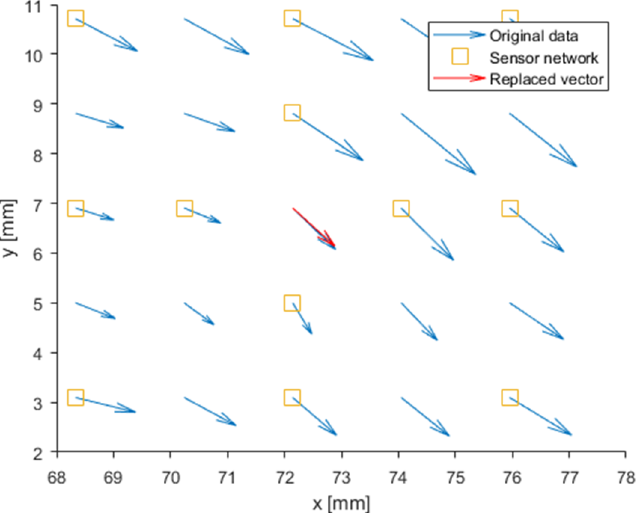
Figure 8. Calculated replacement vector for VP 1 at t = 2503. The original data is overlaid for comparison. Sensor locations highlighted for reference.